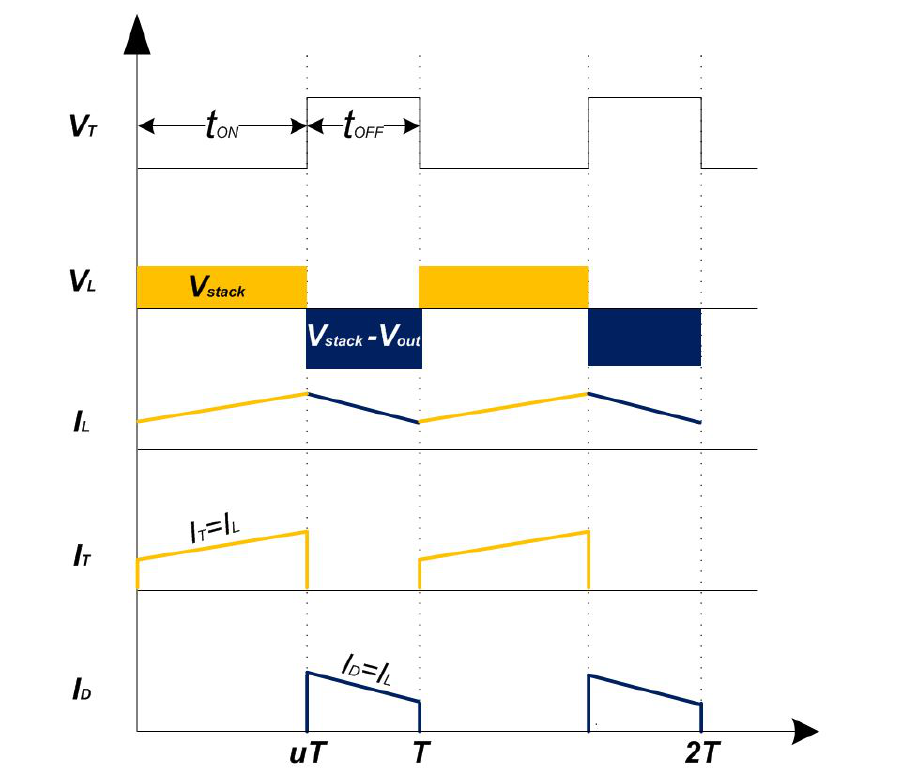
Figure 6. Waveforms of voltages and currents under